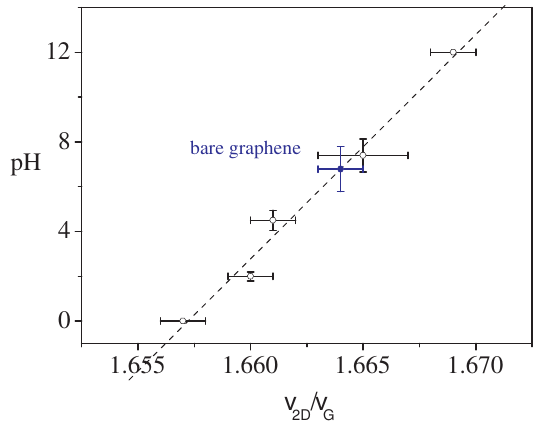
Figure 3. Dependence of the pH value on the ratio between the spectral position of 2D and the G Raman modes detected from the Raman spectra of aqueous solutions with different pH levels (0, 2.0, 4.5, 7.4, 12.0). The data referring to pristine graphene are also reported (blue symbol). The ν 2 D / ν G value for bare graphene is reported in Figure 3 (blue symbol) for comparison. It